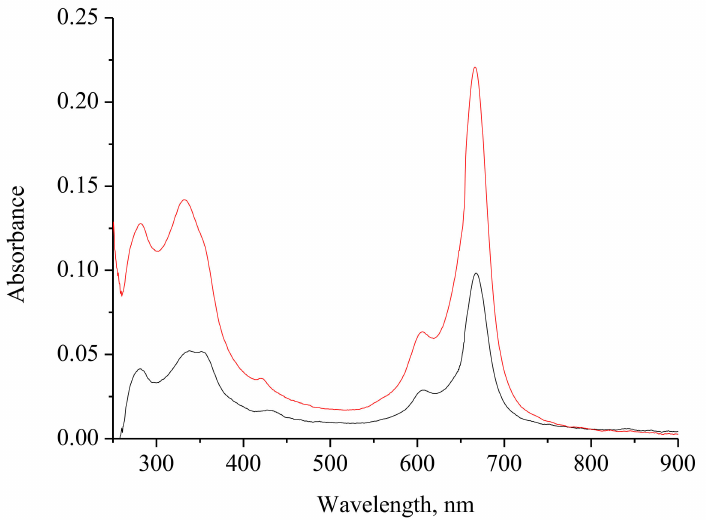
Figure 6. UV-Vis spectra of CoPc in DMF obtained by extraction from the initial CS-CoPc (black line) and heated to 225 ◦ C CS-CoPc (red line) with